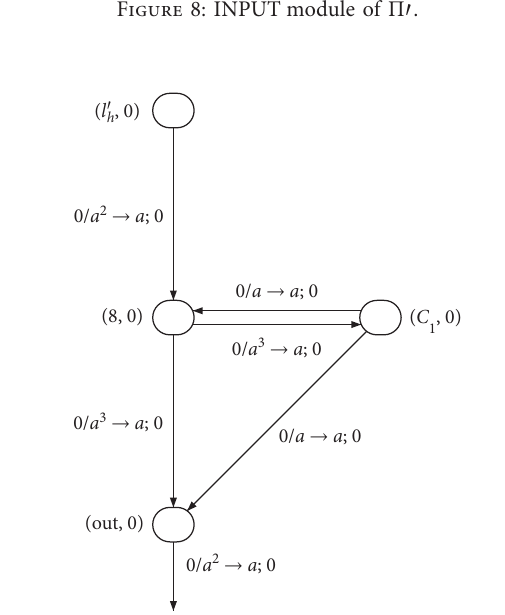
Figure 8: INPUT module of Π